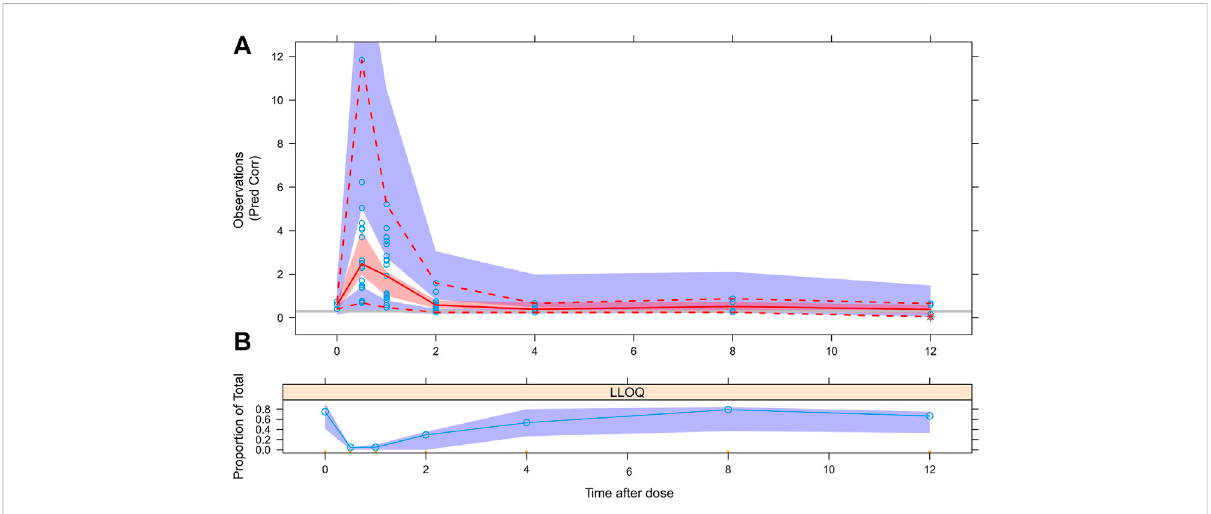
FIGURE 6 VPC evaluation of BQL data with M5 method. (A) Circles represent observations. Red solid line stands for the median of simulated concentrations, and red imaginary lines stand for the 90% PI (5%, 95%) of the predictive MPA concentrations. Shaded areas represent the 95% CI for eachline.ThehorizontalgraylinerepresentstheLLOQ. (B) CirclesrepresentBQLobservations,shadedareasrepresentthe95%CIforpredictiveBQL